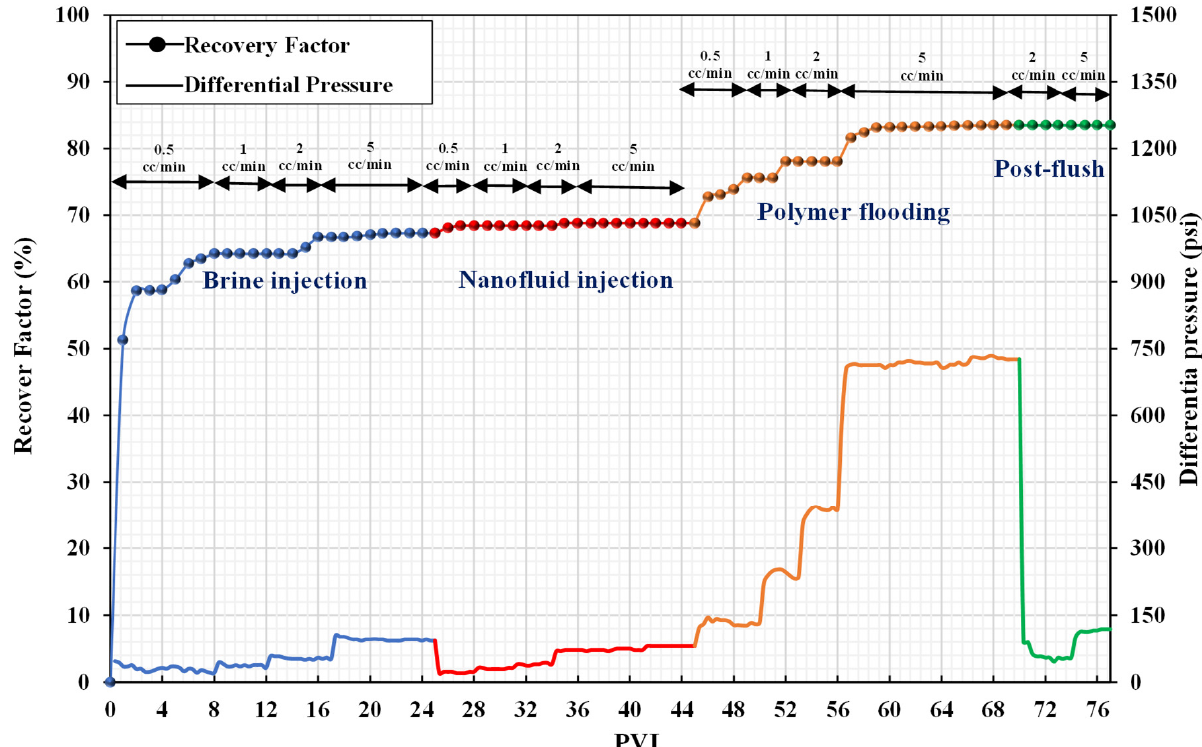
Figure 8. Recovery factors and differential pressure versus PVI (coreflood-2).